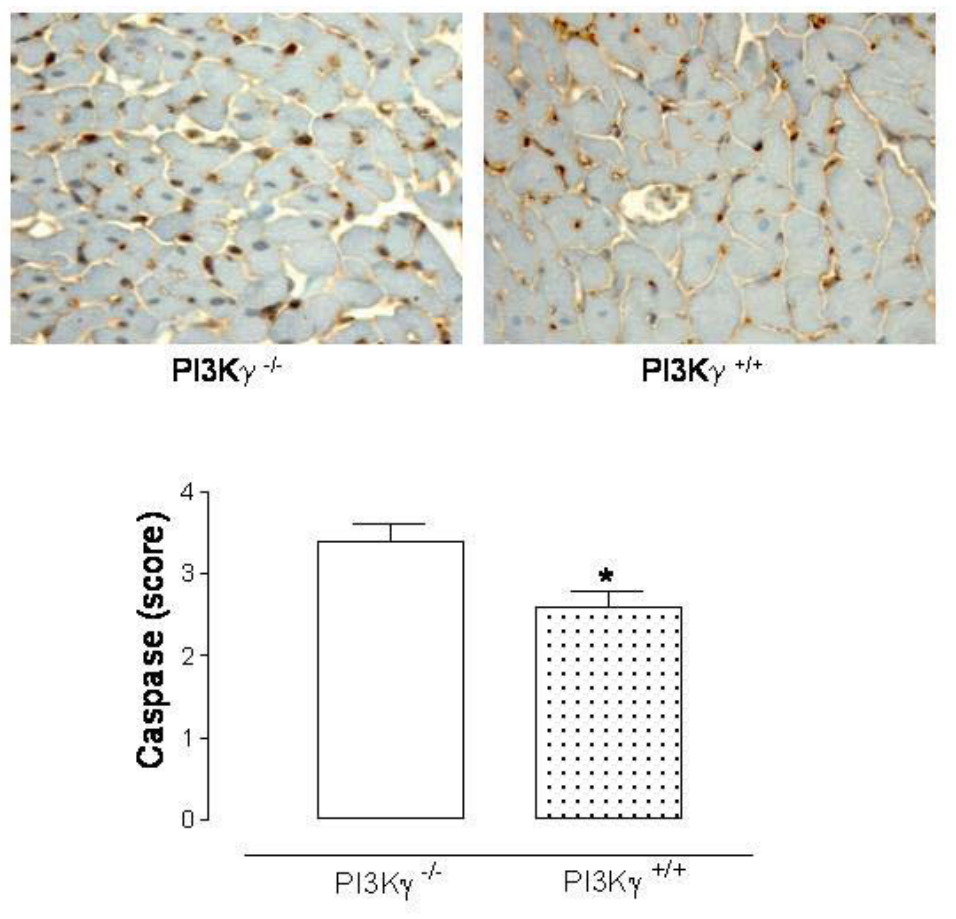
Figure 3. Caspase-3 immunostaining (Panel A) and caspase-3 score (Panel B) in infarcted hearts from PI3k γ -/- and PI3K γ +/+ mice. Sections of infarcted myocardial tissue were incubated with anti caspse-3 polyclonal antibody (1:2000 in PBS v/v) and with secondary antibody. In order to confirm that the immunoreaction for the caspase-3 was specific some sections were also incubated with the primary antibody (anti caspase-3). The sections were then scored for intensity of immunostaining (0=absent, 1=faint, 2= moderate, 3=intense) for each antibody, and average value was calculated for each section. *P<0.01 vs PI3K γ -/-